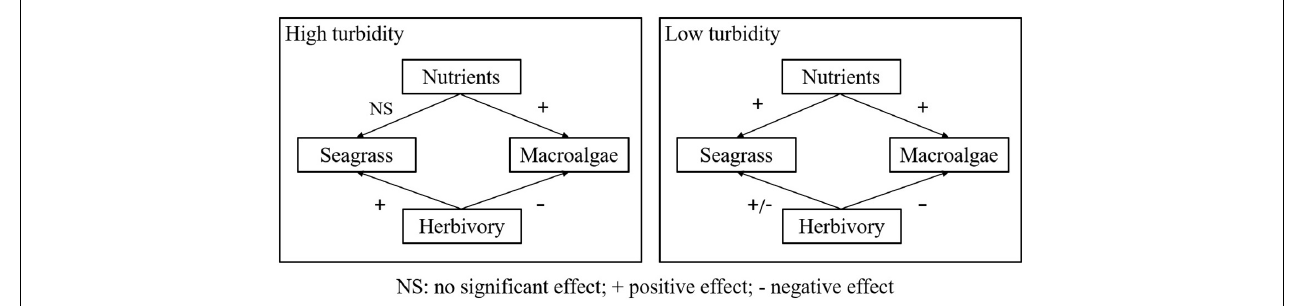
FIGURE 6 | A schematic diagram summarizing the combined effect of nutrient enrichment and herbivory on seagrass and macroalgae in high and low turbidity